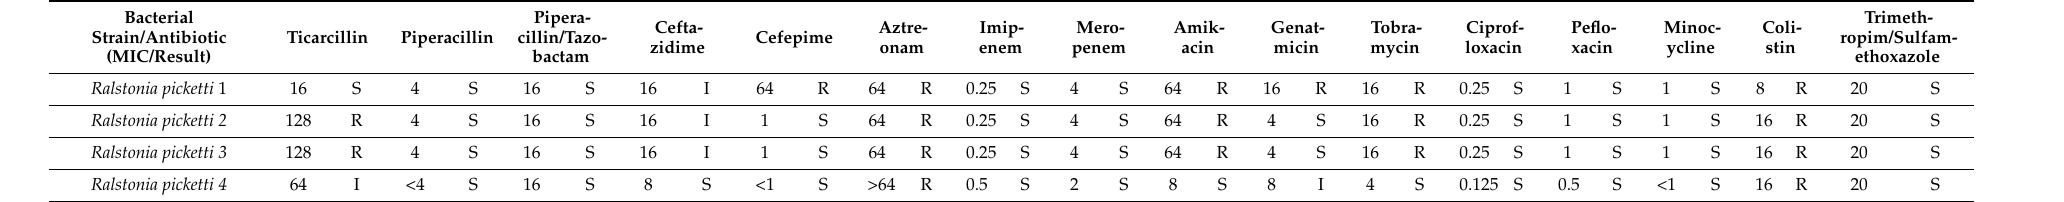
Table 11. MICs (mg/L) of antimicrobials for Ralstonia picketti